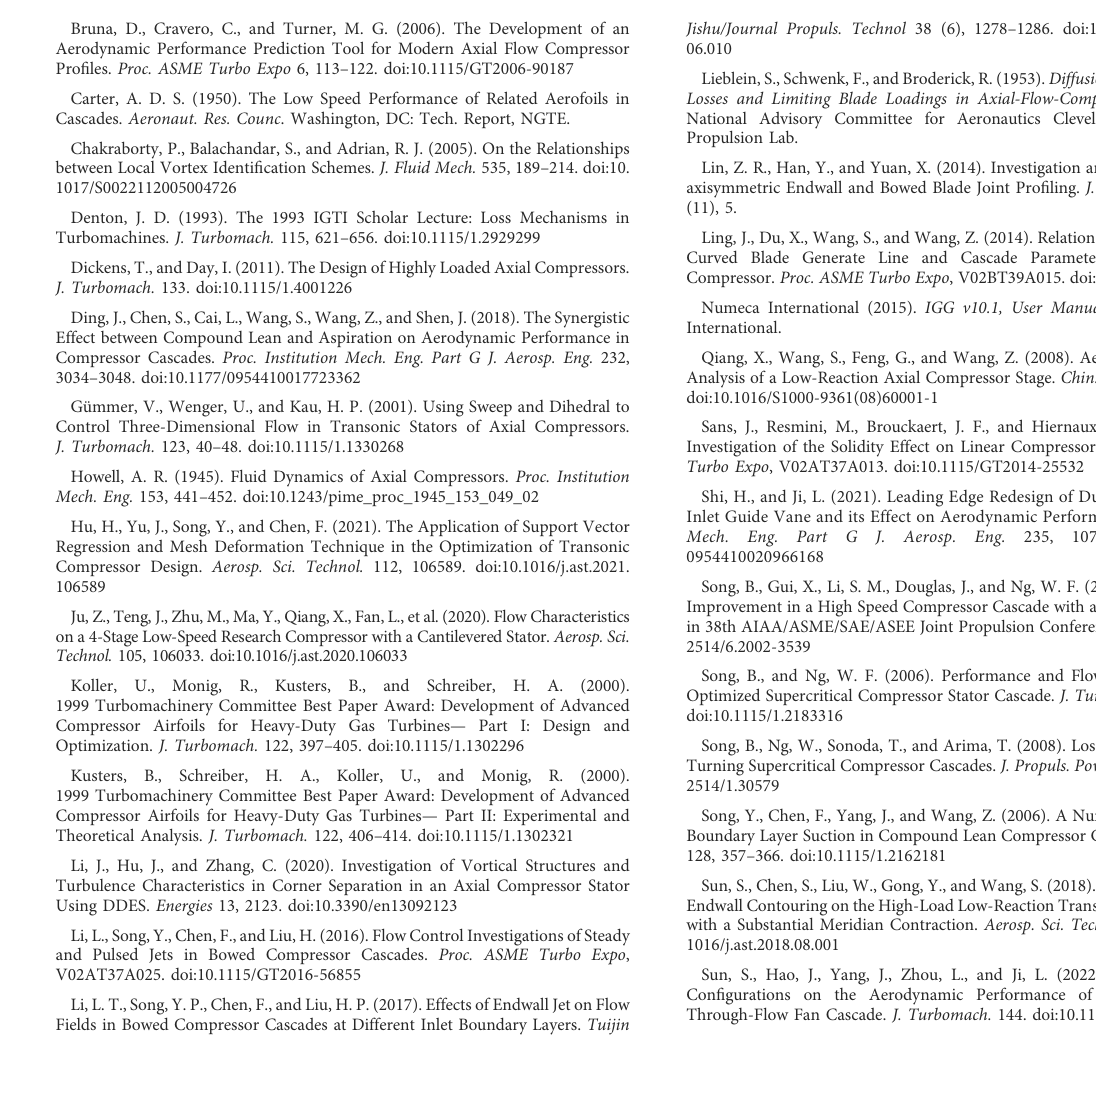
SUPPLEMENTARY FIGURE S30 3-D streamlines and distribution of total pressure loss coef fi cient across the trailing edge of straight blade and compound lean blade with the dihedral angle of 30 ° at the incidence angle of 0.5 ° . ( h/b = 1, Ma = 0.8, θ = 50 ° , σ = 1.8) (A) α = 0 ° ; (B) α = 30 ° . SUPPLEMENTARY FIGURE S31 Radial pressure gradient and surface limiting streamlines on the pressure surface,transversepressuregradient and surfacelimiting streamlineson theendwall,andthedistributionoftotalpressurelosscoef fi cientacross thetrailingedge( h/b =1, σ =1.8, θ =50 ° ) (A) α =0 ° , i =0 ° ; (B) α =20 ° , i =0 ° ; (C) α =30 ° , i =0 ° ; (D) α =0 ° , i =0.1 ° ; (E) α =20 ° , i =0.1 ° ; (F) α =30 ° , i =0.1 ° ; (G) α =0 ° , i =0.25 ° ; (H) α =20 ° , i =0.25 ° ; (I) α =30 ° , i =0.25 ° ; (J) α =0 ° , i = 0.5 ° ; (K) α = 20 ° , i = 0.5 ° ; (L) α = 30 ° , i = 0.5 ° ; (M) α = 0 ° , i = 0.7 ° ; (N) α = 20 ° , i = 0.7 ° ; (O) α = 30 ° , i = 0.7 ° . SUPPLEMENTARY FIGURE S32 Vortex structures identi fi ed by the iso-surface with Q = 5,000 of straight blade and compound lean blade with the dihedral angle of 30 ° at the incidence angle of 0.5 ° ( h/b = 1, Ma = 0.8, θ = 50 ° , σ = 1.8) (A) α = 0 ° ; (B) α = 30 °